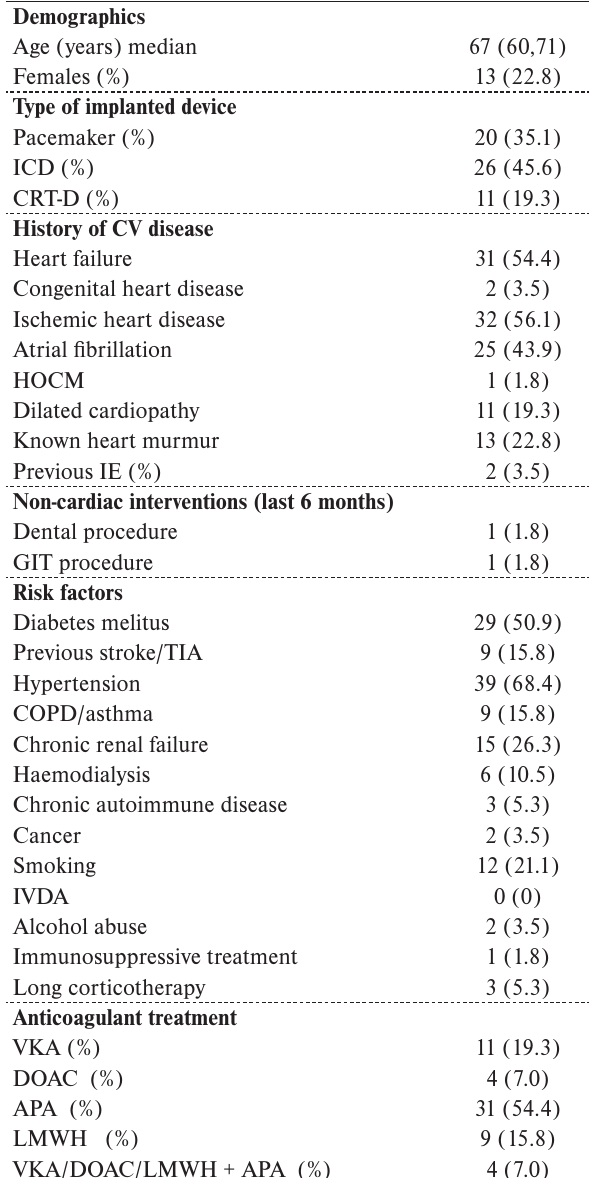
Table 1. Patient demographics and